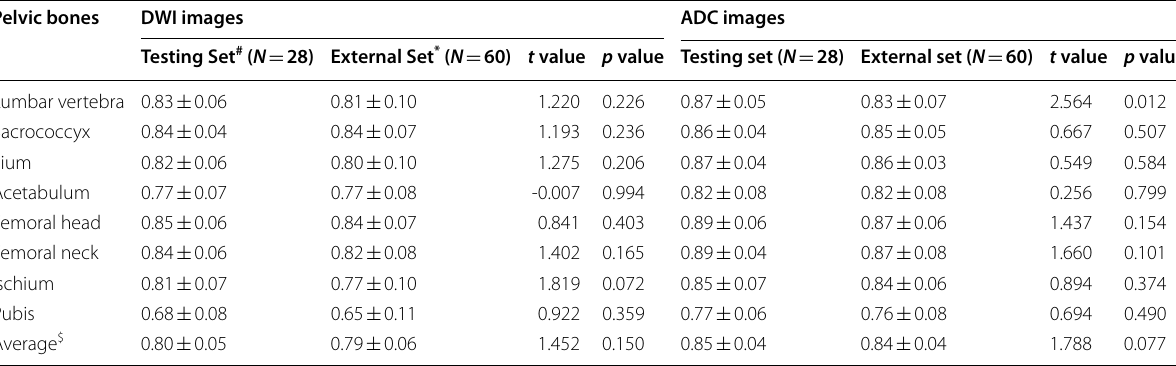
Table 3 The DSC values of 3D U-Net in pelvic bones segmentation on DWI and ADC images Pelvic bones DWI images ADC